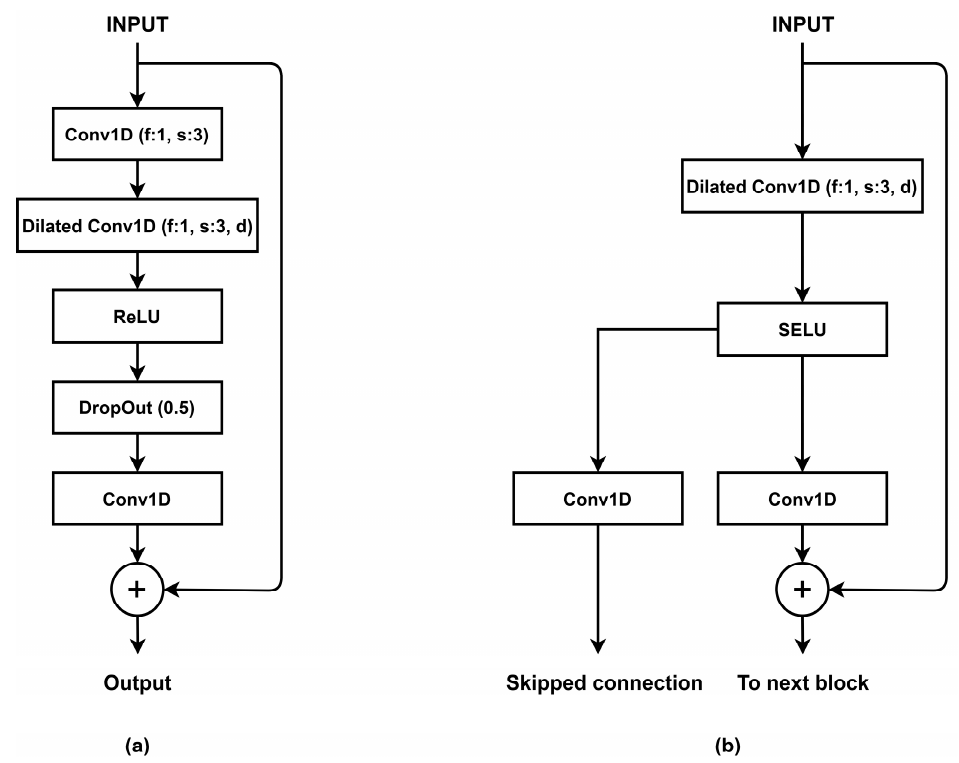
( a ) Residual dilated convolution block with ReLU activation and a dropout layer. Figure 5 . (a) Residual dilated convolution block with ReLU activation and a dropout ( b ) Self-normalizing residual block with scaled exponential linear unit (SELU) activation and layer. (b) Self-normalizing residual block with scaled exponential linear unit (SELU) skipped activation and skipped connection.